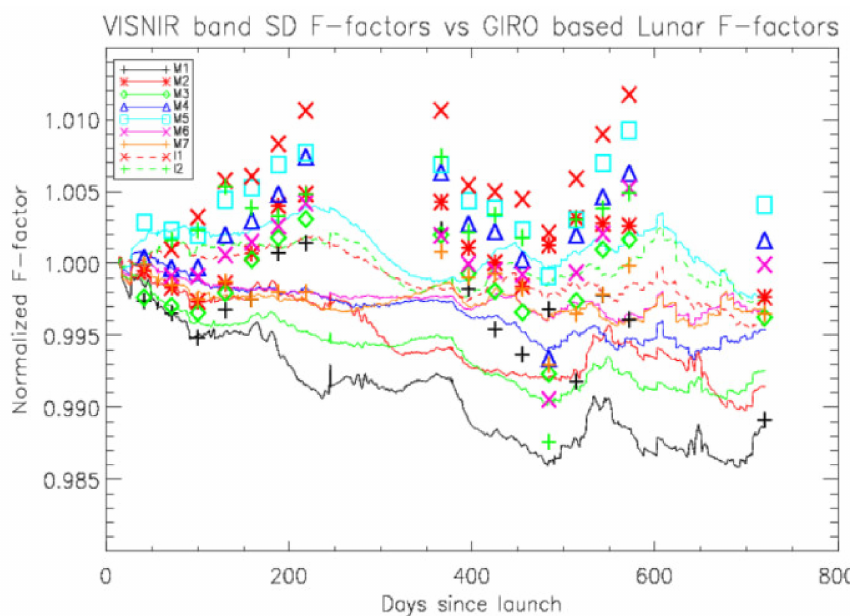
Figure 7. Suomi National Polar-Orbiting (SNPP) and National Oceanic Atmospheric Administration (NOAA)-20 VIIRS Solar Di ff user (SD) and lunar F-factor long-term trends. Solid lines represent SD F-factors and symbols represent F-factors derived from lunar calibration. Colors represent spectral bands.